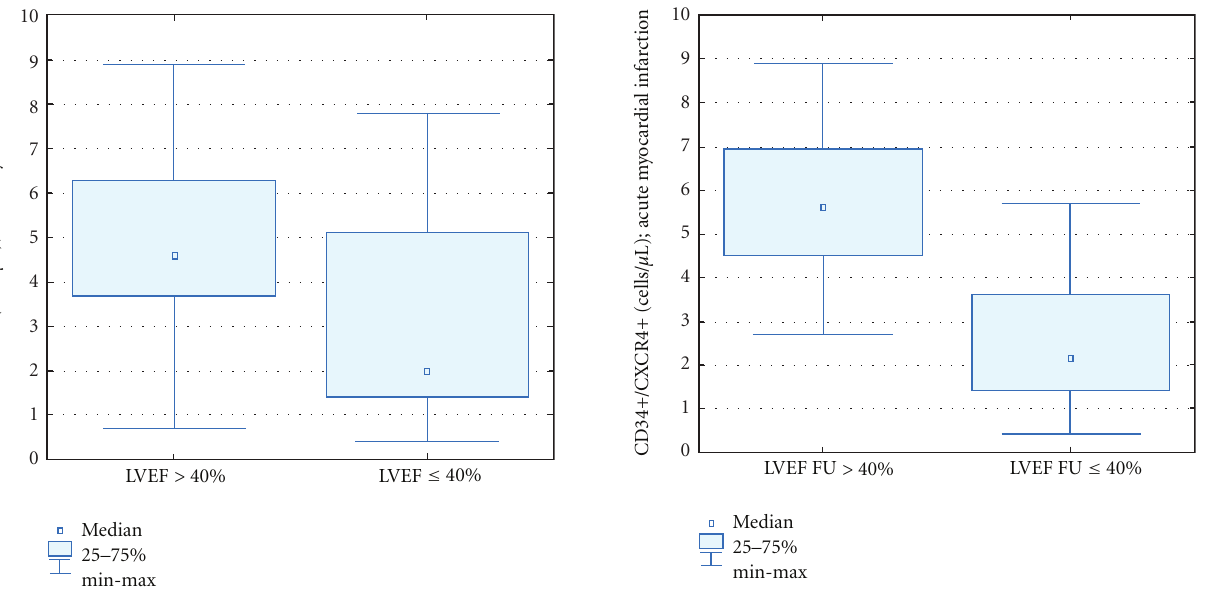
Figure 4: Circulating CD34+CXCR4+ cells in the acute phase of MI in patients with LVEF > 40% versus ≤ 40%.